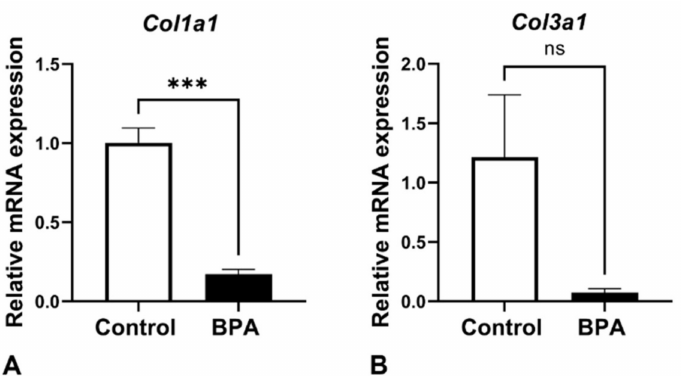
Figure 4. Col1a1 ( A ) and col3a1 ( B ) gene expression in the control and BPA-treated groups. Note: no significant differences (ns), *** p <